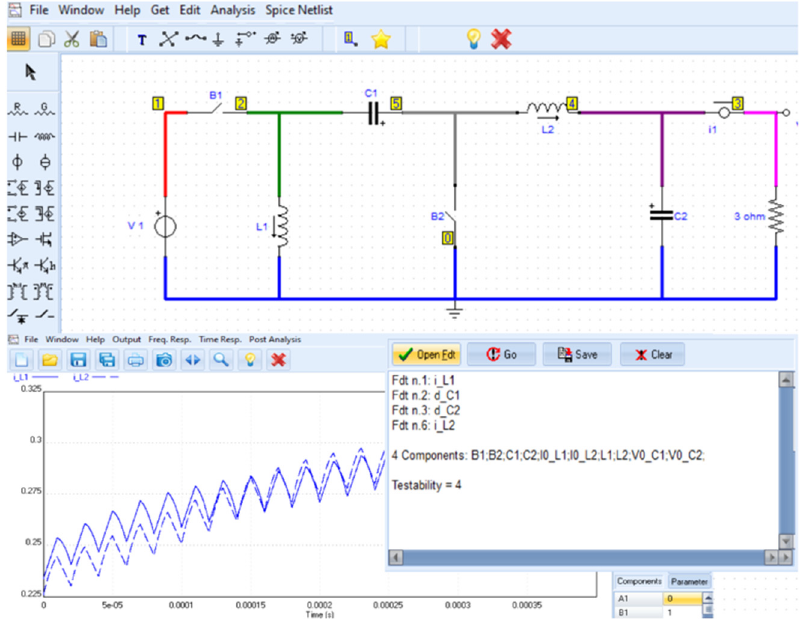
Figure 8. Testability analysis of the Zeta converter through SapWin and TAPSLIN.